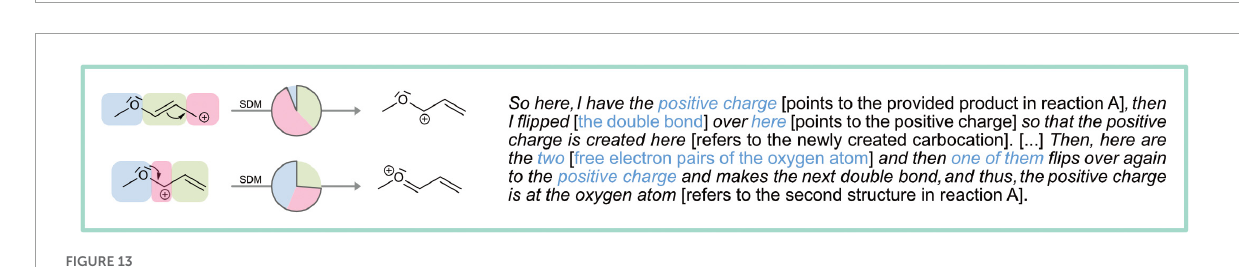
FIGURE12 Elizabeth’s drawing move, fixation duration rate on the structural features and drawing description for her drawing in reaction B. The orange frame indicates the unproductivity of the resulting drawing.